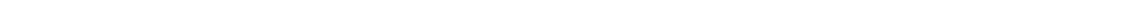
Fig. 5 Insc ASYM induces ACDs in p53-KO mammary stem cells. a Insc transcript levels evaluated by RT – qPCR on mammospheres from wild-type FVB mice, or p53-KO mice infected with empty lentivirus (EV) or human full-length Insc (INSC) normalized to the Rpp0 control. Bars represent mean ± s.d. of three replicates. Statistics for 1 out of 2 independent experiments. b , c Images and quanti fi cation of the division mode of mammary epithelial cells from p53-KO mice evaluated by pair-cell assay. Cell infected with empty lentivirus (EV) or virus expressing full-length Insc (INSC) were stained with CD49f and DAPI. Scale bar, 10 μ m. Quanti fi cation from 2 independent experiments with n > 10 cells for all conditions in each experiment. p = 0.005 according to the paired Student ’ s test. d Scheme of the SFE assay used to evaluate self-renewal of p53-KO MaSCs. Stem cells are in blue, progenitors in pink. e Number of mammospheres from p53-KO mice infected with an empty lentivirus (EV) or a virus expressing Insc (INSC) counted over three serial passages and shown by box-plots with mean of 10 wells count per each passage (green line). f – h SFE assays with p53-KO mammospheres infected with empty virus (EV) or viruses expressing Insc (FL), Insc ASYM (aa 1 – 317, ASYM), or Insc PEPT (aa 1 – 58, PEPT). For each passage, the number of spheres ( f ), the sphere area ( g ) and the GFP intensity ( h ) have been evaluated for 10 wells, and plotted as in e (each pair Student ’ s t -test). Statistics for 1 out of 3 independent experiments. i SFE assays performed with p53-KO mammospheres infected with empty lentivirus (EV) or viruses expressing Insc (FL), Insc ASYM (ASYM), or Insc ASYM - Δα B (i.e. Insc ASYM lacking aa 62 – 191). For each passage, the number of spheres has been counted for four wells, and plotted as above (each pair Student ’ s t-test). Statistics for one out of two independent experiments. j SFE assays performed with p53-KO mammospheres infected with empty lentivirus (EV) or viruses expressing Insc (FL), human LGN-GoLoco (aa 358 – 677) or both. For each passage, the number of spheres has been evaluated in three wells, and plotted as above (each pair Student ’ s t -test). In the fi gure, * P < 0.01, *** P < 0.001 by Wilcoxon ’ s